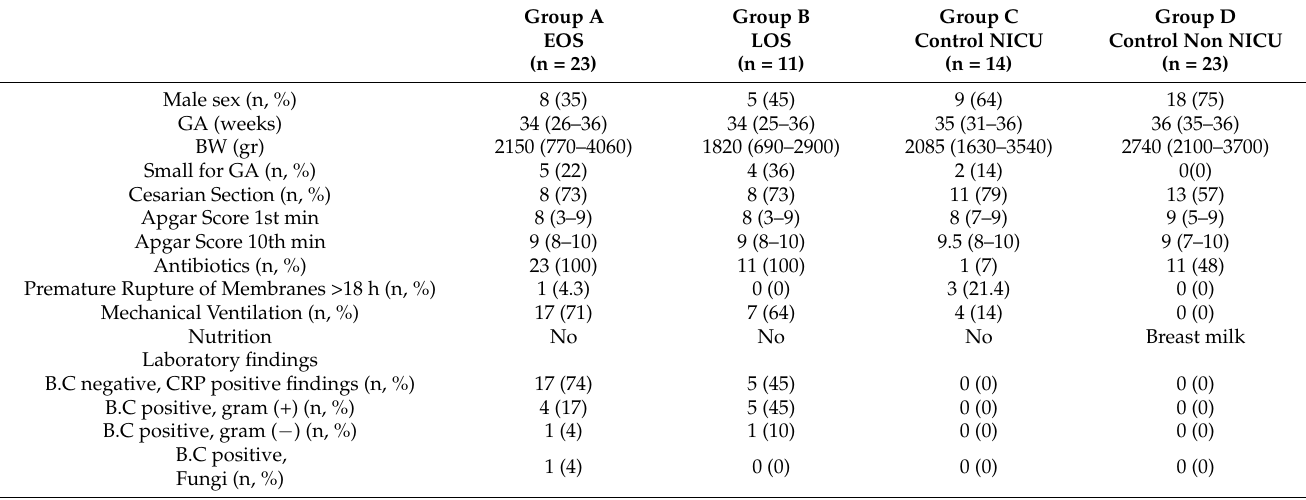
Table 1. Clinical characteristics and laboratory findings for septic and control neonates. Median and (minimum–maximum) values of the GA, BW, Apgar Score for the first and tenth minute of life, the number (percentage) of the male sex, the delivery mode (cesarian section), the small for gestational age (SGA) infants, the newborns with premature rupture of membranes (>18 h), treatment with mechanical ventilation and/or antibiotics, blood culture positive (Gram-positive, Gram-negative and fungi) and c reactive protein